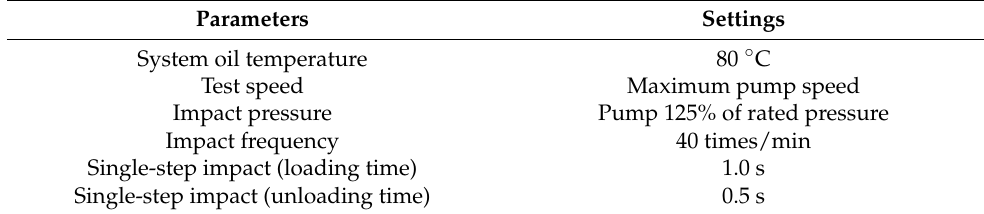
Table 1. Parameter setting for the impact test